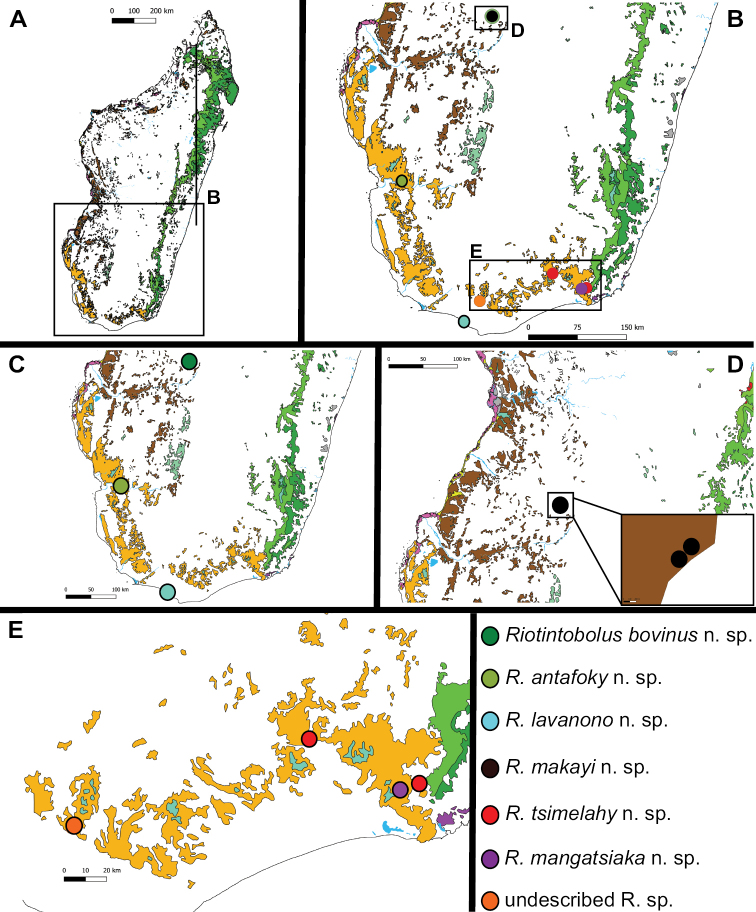
Distribution of the newly described Riotintobolus species, as well as of the still undescribed species. Vegetation marks modified from Moat and Smith 2007.